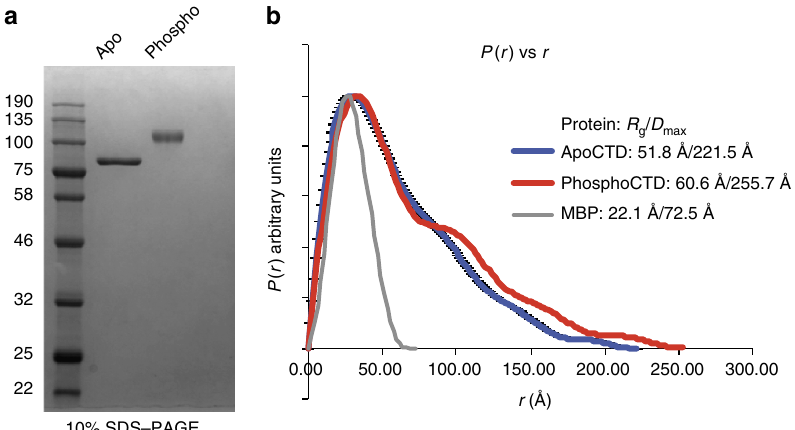
Figure 2 | The CTD extends as a function of phosphorylation. ( a ) Coomassie blue stained 12% SDS–PAGE gel of 600ng of apo or phospho MBP- D.mel CTD used for SAXS experiments. ( b ) Pairwise distance distribution ( P ( r ) versus r ) plots of the apo (blue line) and phospho (red line) MBP- D.mel CTD, and the CRYSOL generated scattering curve of MBP (grey line). The phospho CTD adopts a more extended conformation compared to the apo CTD, with increases in R g and D max .